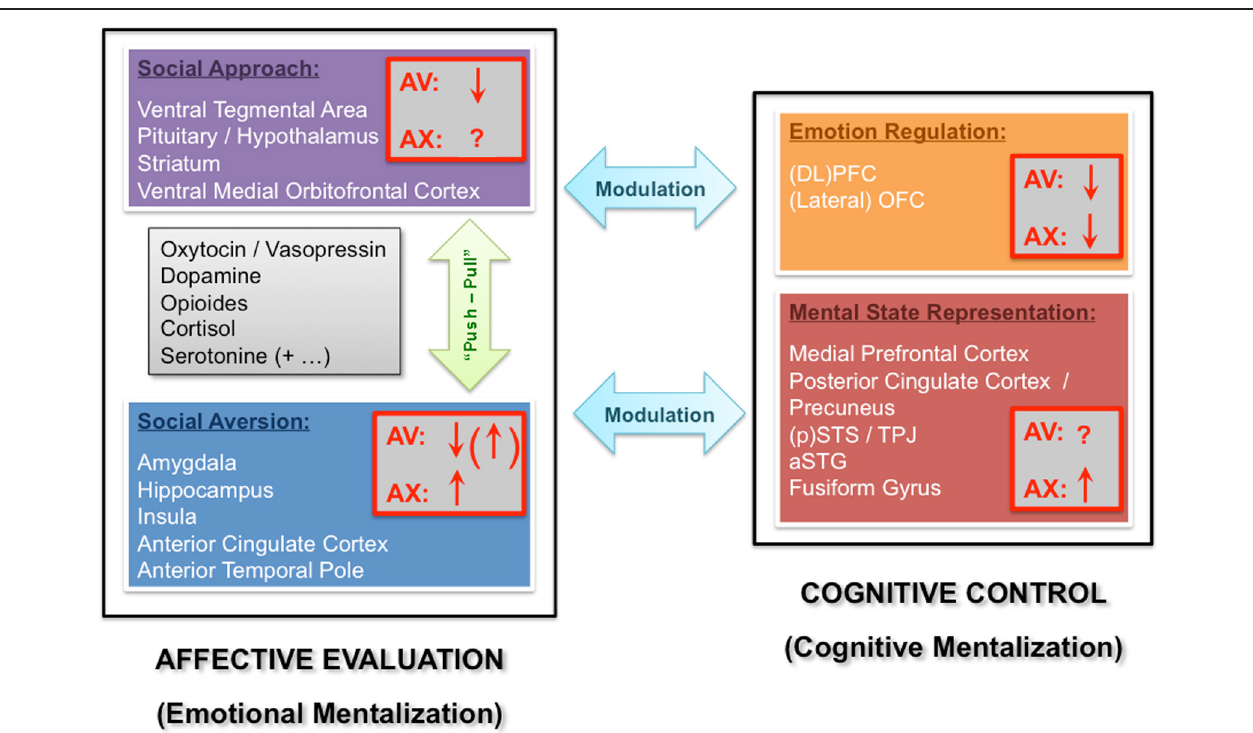
FIGURE 1 | Functional neuroanatomical model of the influence of adult attachment style on social processing. Two core component networks mediate relatively automatic affective evaluations versus more controlled cognitive processes, broadly corresponding to emotional versus cognitive mentalization mechanisms proposed in other models (Fonagy and Luyten, 2009). The affective evaluation component further comprises social approach (purple) versus aversion (blue) systems, whereas the cognitive control component comprises distinct systems implicated in emotion regulation (orange) and mental state representation (red). We assume “push-pull” effects between approach versus aversion modules (green arrow), which